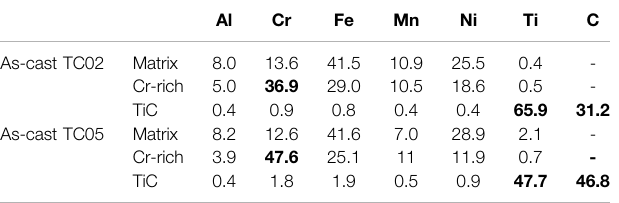
TABLE 2 | EDS analysis of as-cast alloys (at%).